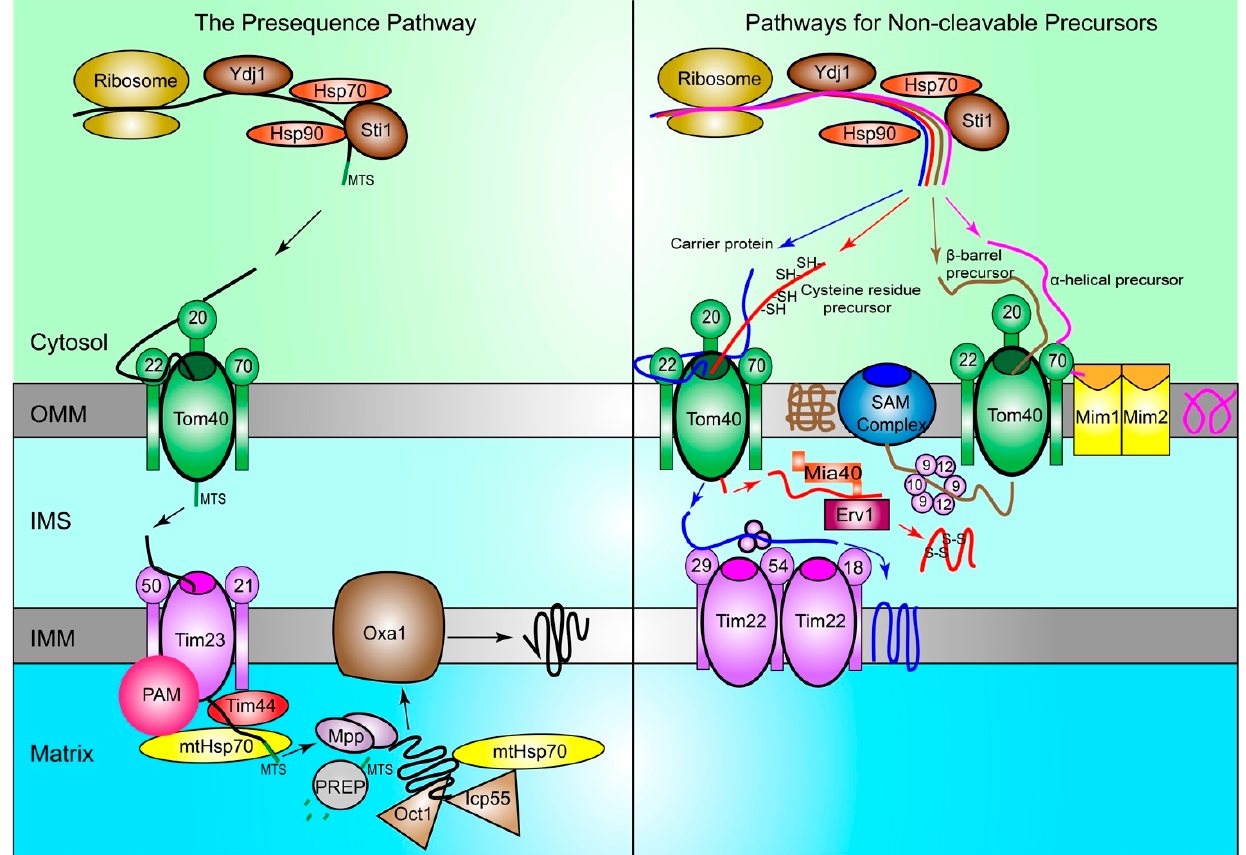
Figure 1. Proteins are imported into mitochondria through multiple pathways. In yeast, protein precursors are synthesized by ribosomes in the cytosol and guided to the TOM complex on the OMM by chaperone Hsp70 and Hsp90, with the help of co-chaperones Ydj1 and Sti1. In the presequence pathway (left), precursors are first recognized by Tom20 of the TOM complex in the cytosol. Then, precursors are handed to Tom22 and subsequently brought through the Tom40 channel into the IMS. They are received by Tim50 of the TIM23 complex on the IMM and passed through to the matrix, with the help of the Tim44 protein and mtHsp70. The PAM complex prevents precursors from moving backwards out of the TIM23 complex. MPP cleaves the MTS to release proteins. Icp55 and Oct1 help remove any unstable amino acids from the N-terminal cleavage site of the proteins. Then, the presequence is degraded by PREP, and Oxa1 helps integrate mature proteins into the IMM when needed. In the pathways for non-cleavable proteins (right), carrier proteins (blue), proteins with cysteine residues (red), α -helical (purple), and β -barrel (brown) are shown. Carrier proteins pass through the TOM complex via the Tom40 channel into the IMS. Then, they are carried to their final location in the IMM by the TIM22 complex and other IMS chaperones. Precursors with cysteine residues also pass through the TOM complex via the Tom40 channel. Then, they are received by Mia40, which is regulated by Erv1, and helps create the disulfide bonds between cysteine residues and form mature proteins. α -helical precursors rely on Tom70 for recognition and do not localize to the IMS, as they are integrated into the OMM by the MIM complex. β -barrel precursors pass through the Tom40 pore into the IMS, and then moved to the SAM complex on the OMM via Tim chaperones, including Tim9, Tim10, and Tim12. Then, the SAM complex incorporates the mature proteins into the OMM. TOM: translocase of the outer membrane; OMM: Outer mitochondrial membrane; Hsp70: Heat-shock protein 70; Hsp90: Heat-shock protein 90; Ydj1: Yeast dnaJ 1; Sti1: Stress inducible protein 1; IMS: Intermembrane space; TIM: translocase of the inner membrane; IMM: Inner mitochondrial